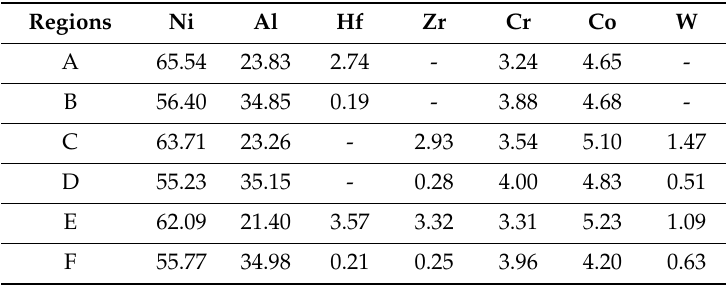
Figure 9. The cross-sectional morphologies of the oxide scales formed on the NiAl coatings after 100 h cyclic oxidation at 1150 ◦ C: ( a ) NiAl–Hf, ( b ) NiAl–Zr, ( c ) NiAl–Hf–Zr. Table 3. Chemical composition of the corresponding regions in Figure 8 (in at.%, electron probe micro-analyzer (EPMA) data).